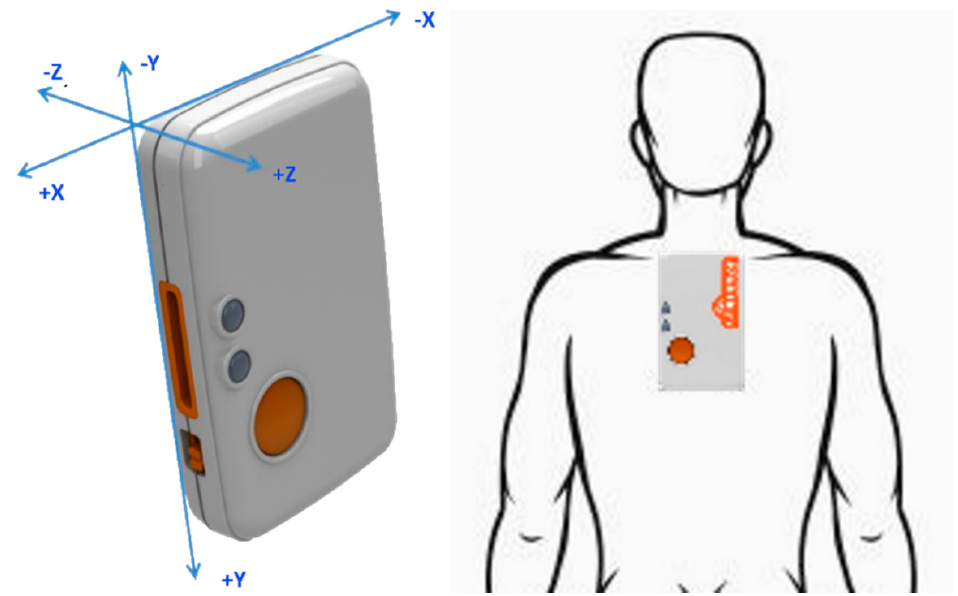
Figure 3. Shimmer axes of rotation demonstrating indicative placement of the IMU .